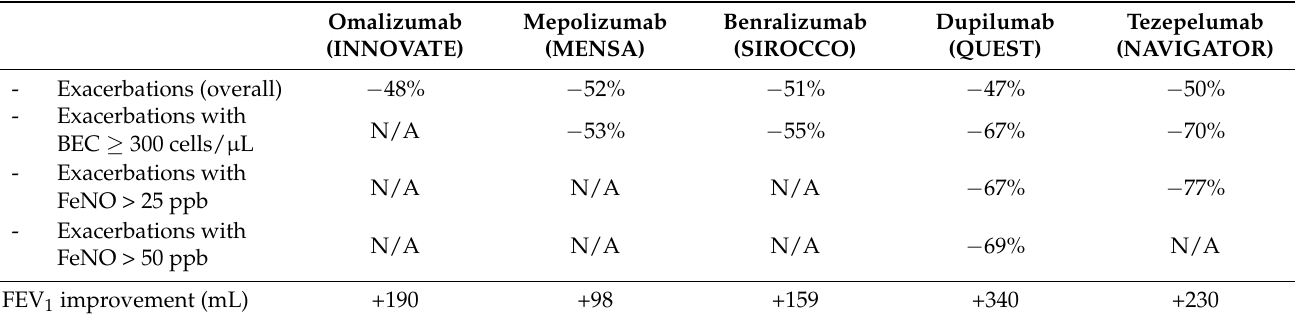
Table 5. Comparison between primary outcomes.